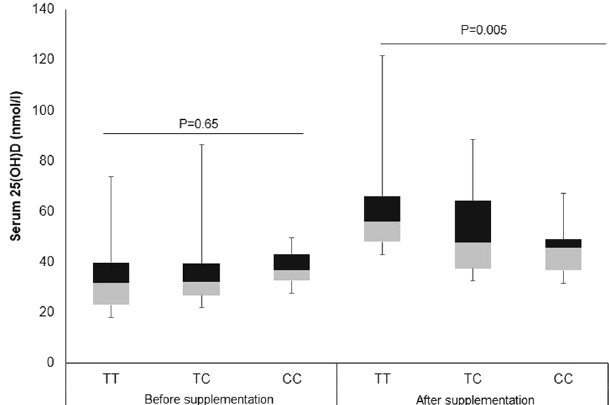
Figure 2. Box plot showing distribution of serum 25(OH)D levels (nmol/L) before and after vitamin D supplementation according to VDR fok-I